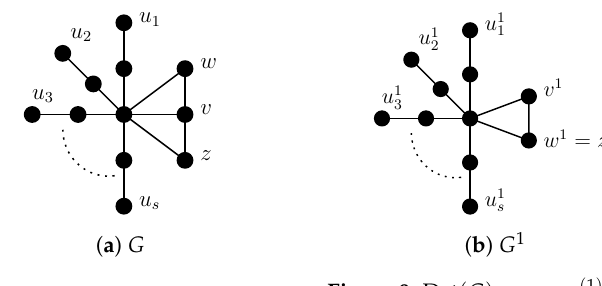
Figure 9. Det ( G ) = n − n ( 1 ) + Det ( G 2 )